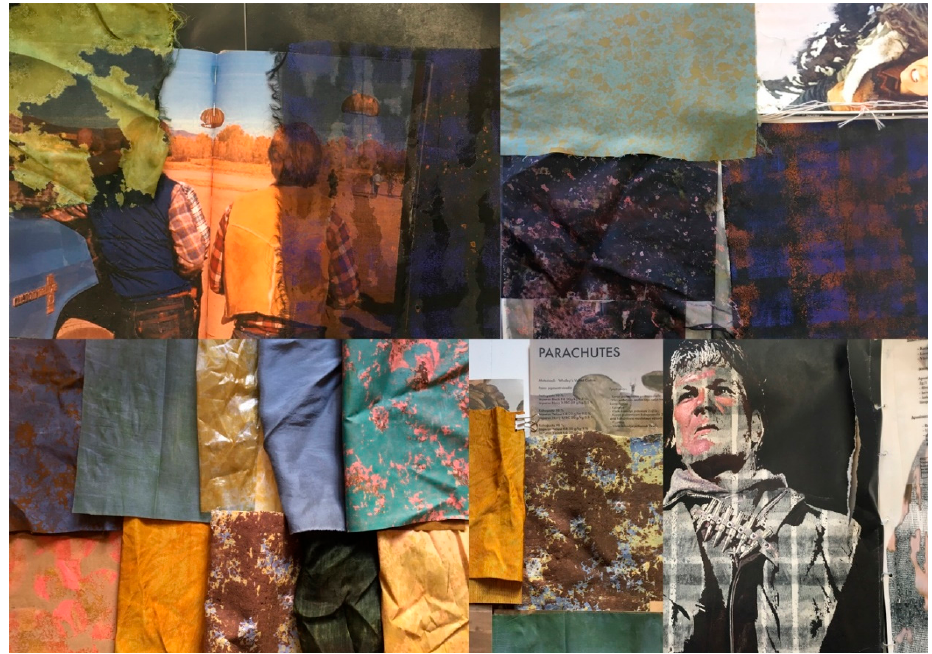
Figure 2. Jarno Kettunen and Anna Semi, 2016. Swatches, research, and info cards from the “Printed Fabrics, Dyeing, and Textile Technology” course. Kettunen and Semi worked on the same fashion collection. The research topic was related to the survival of young people in the desert and in harsh conditions. Inspiration was taken from the 1984 movie Red Dawn by John Milius, and as a counterweight to the theme of survival, from the delicate ice flower sculptures of Japanese artist Azuma Makoto. Photo credits: Jarno Kettunen, Anna Semi (used by permission) .